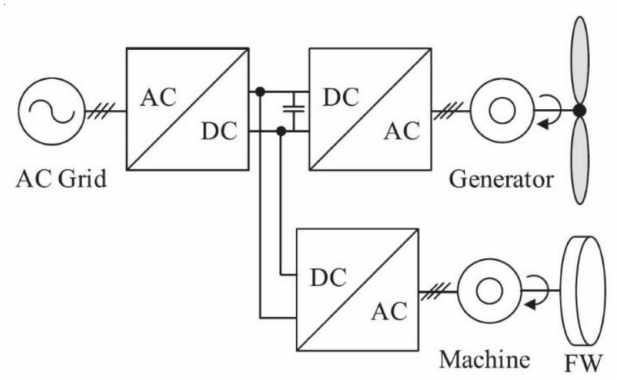
Figure 14. Back to back layout, adapted from [128].